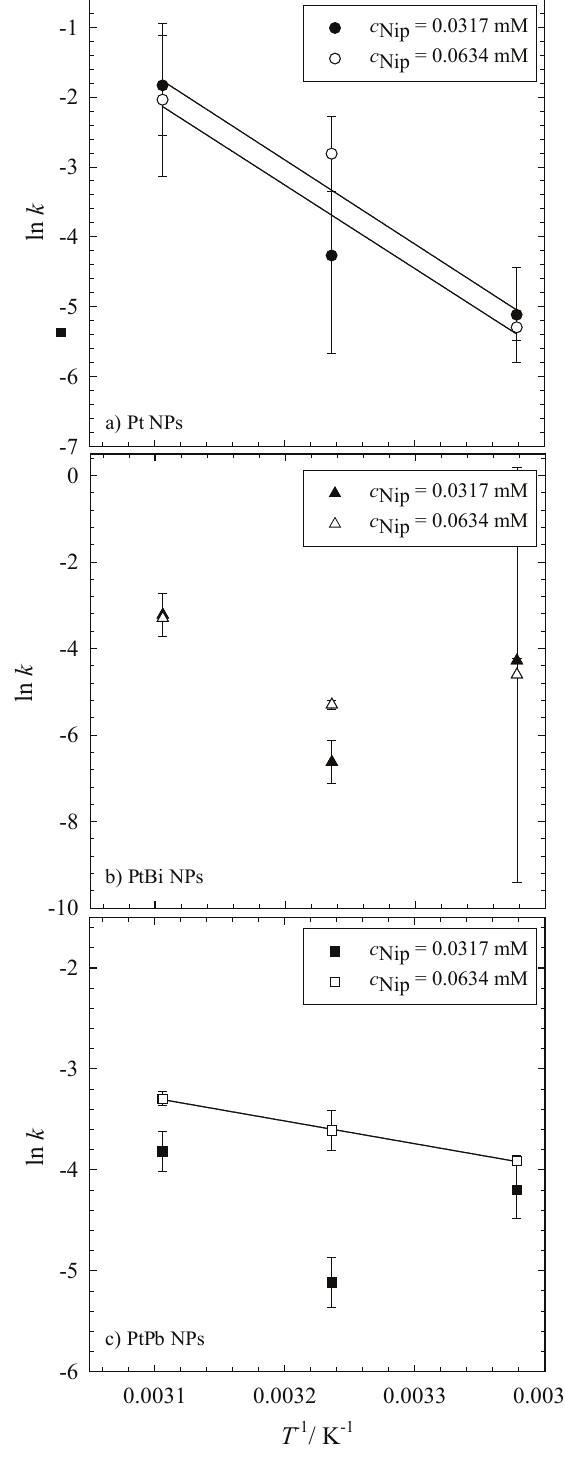
Figure 4. Arrhenius plot of the reduction of 4-nitrophenol to 4-nitrosophenol using NaBH 4 as a reducing agent catalyzed via ( a ) Pt, ( b ) PtBi and ( c ) PtPb nanoparticles. All reductions were performed with 1 mg of catalysts ( i.e. , 0.3 mg Pt, PtPb, PtBi NPs and 0.7 mg of polymer) and a constant concentration of the reducing agent (6.196 mM NaBH ). The 4 reduction was measured at 23 °C, 36 °C and 49 °C. The filled symbols denote the measurements with an initial concentration of c = 0.0317 mM, while the empty symbols Nip denote the measurements with c = 0.0634 Nip